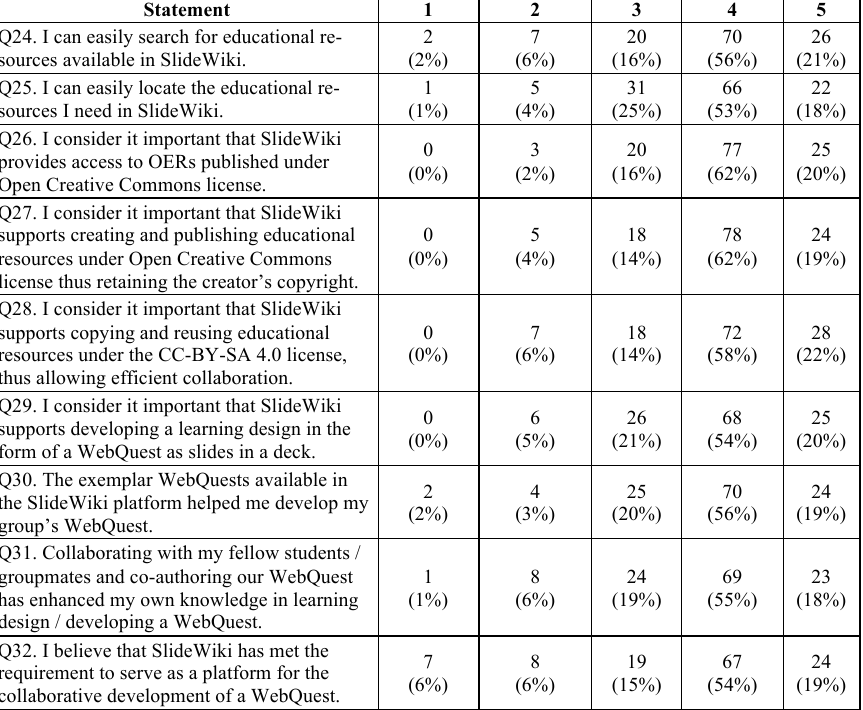
Table 5. Distribution of the students’ responses in statements Q24 to Q32 of Section C Statement 1 2 3 4